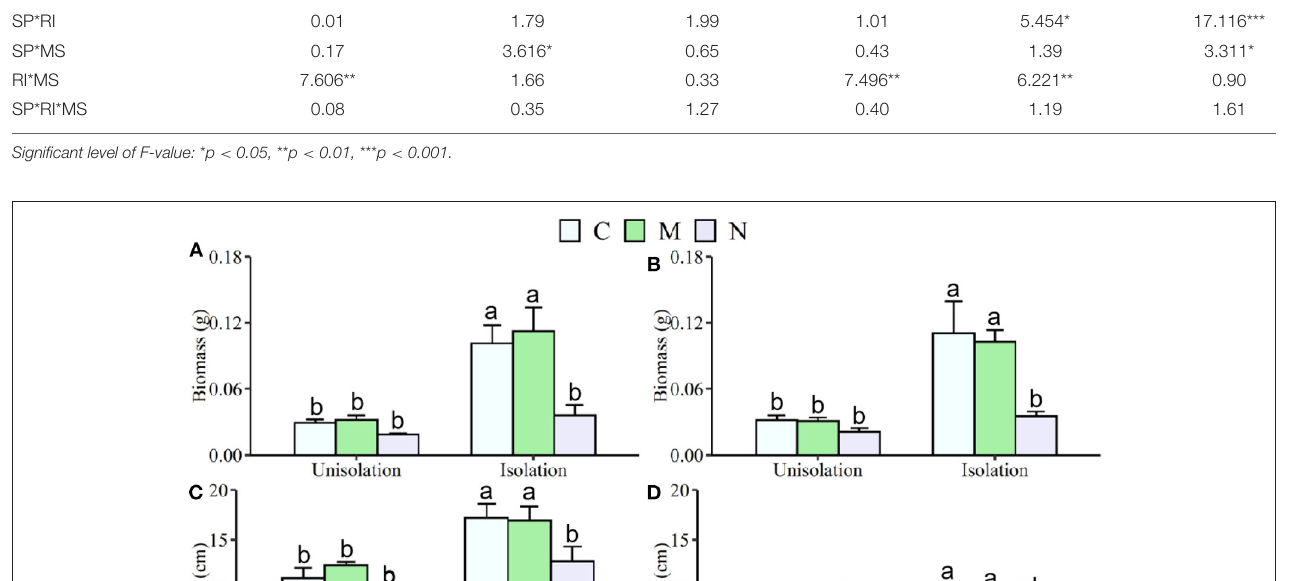
mean individual biomass and survival by 60 and